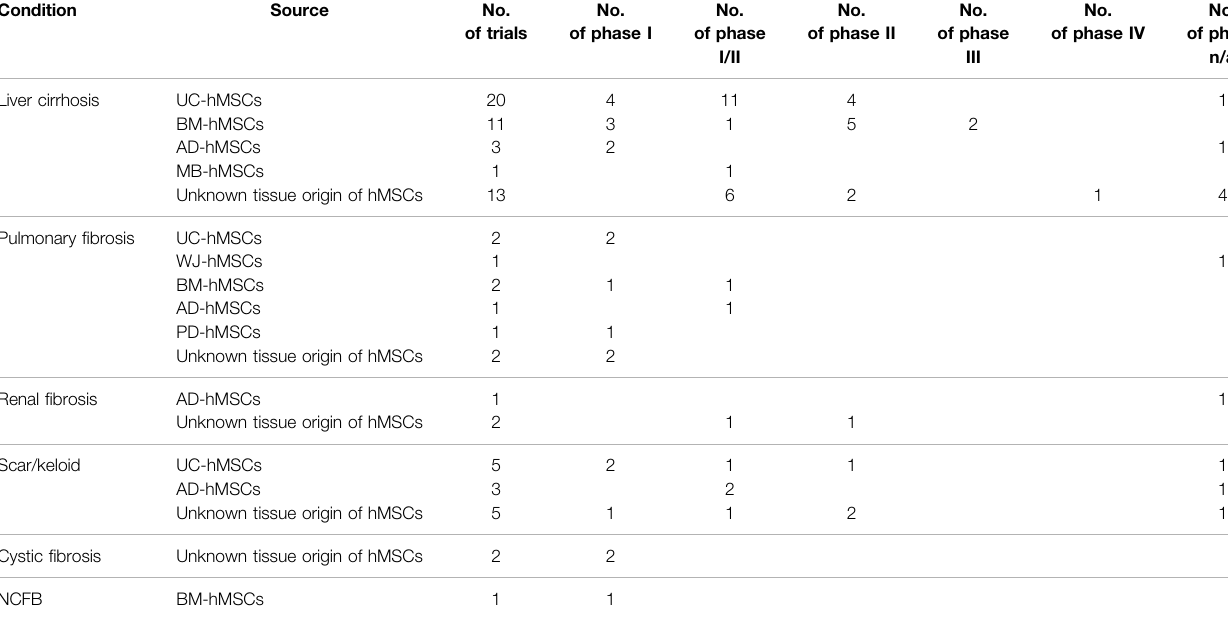
TABLE 1 | Summary of MSC-based anti- fi brotic clinical trials ( n = 76, as of 27 April 2022).